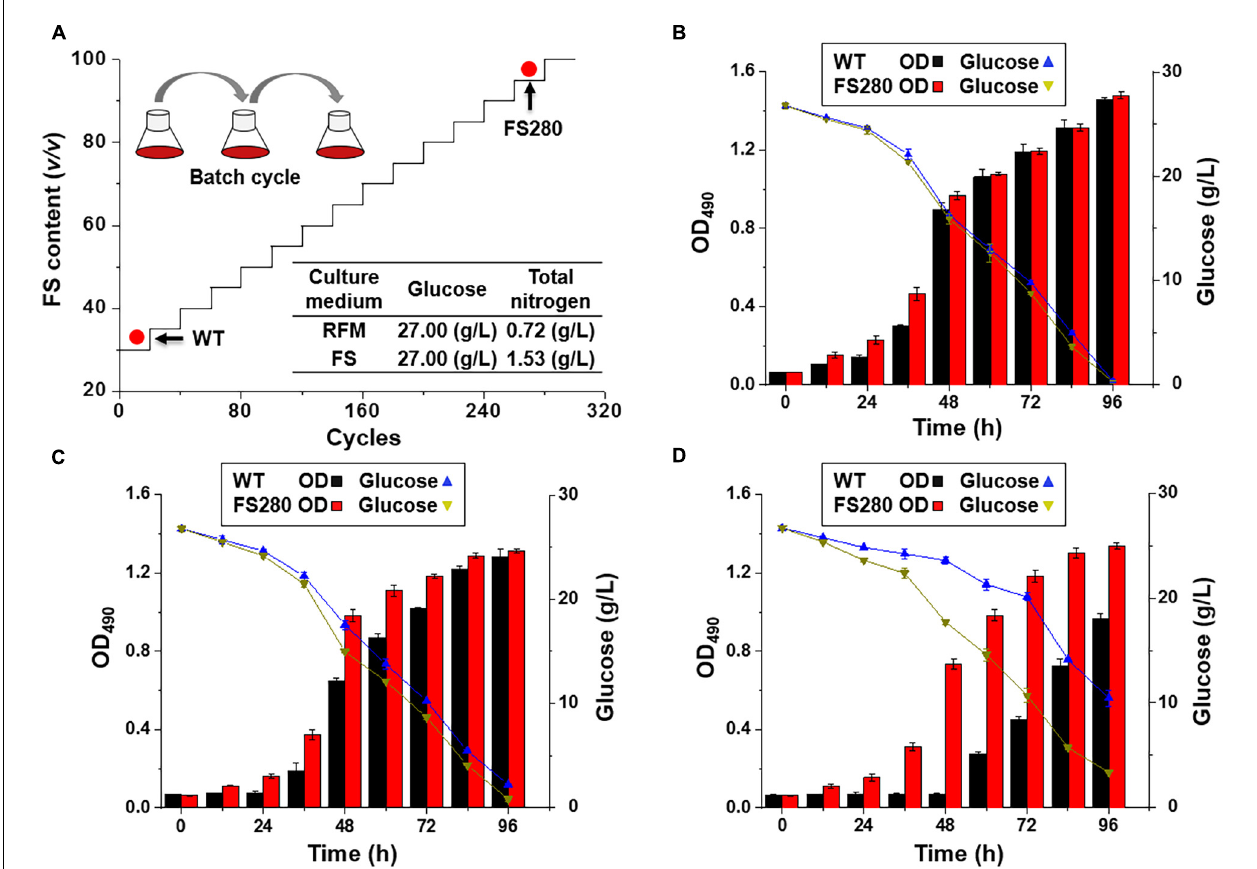
FIGURE 1 | Fermentation supernatant-based adaptive laboratory evolution. (A) The process of ALE: RFM, regular fermentation medium; FS, fermentation supernatant; WT, C. cohnii ATCC 30556; FS280, C. cohnii FS280. (B) Cultivation with 30% ( v/v ) fermentation supernatant. (C) Cultivation with 60% ( v/v ) fermentation supernatant. (D) Cultivation with 90% ( v/v ) fermentation